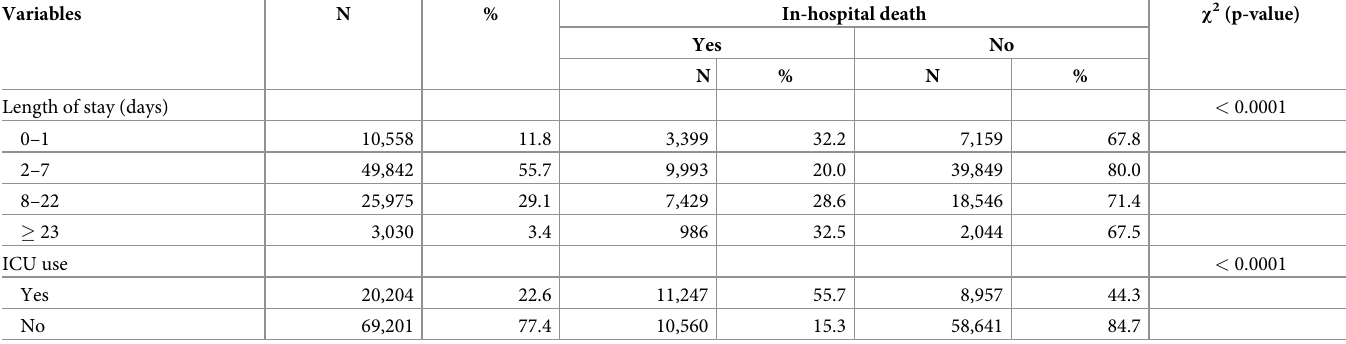
Table 2. Bivariate analyses of variables related to the inpatient healthcare process and in-hospital mortality. COVID-19 hospitalizations in the Unified Health System in Brazil (N = 89,405). February to June 2020. Variables